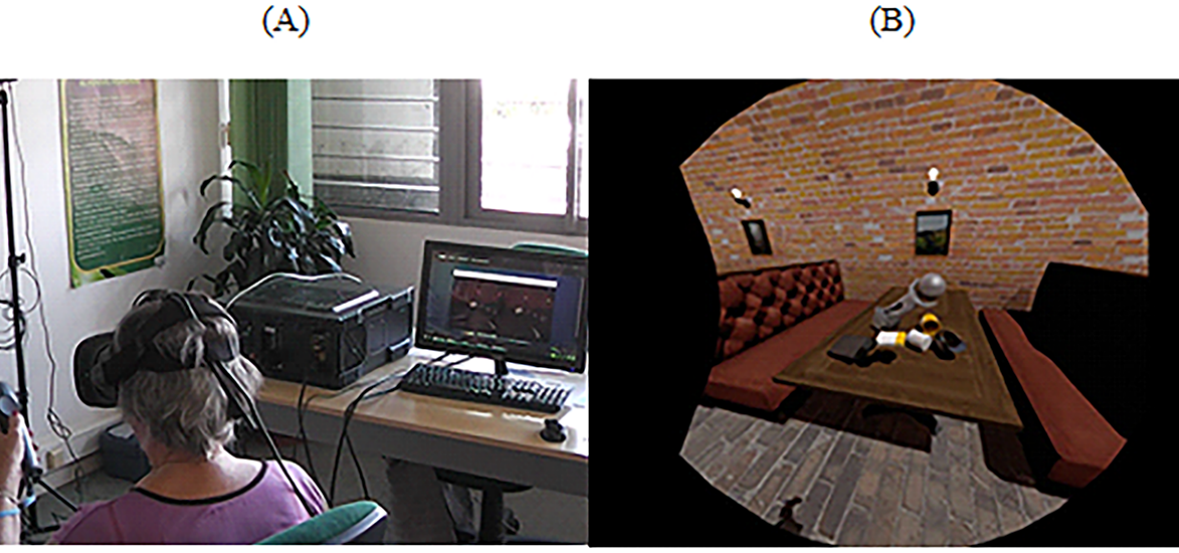
Figure 3. Steam virtual reality home – bar table. (A) Manipulating daily objects using head-mounted display with controllers. (B) Print screen of the task. Participants had to look at and manipulate daily objects that are on the